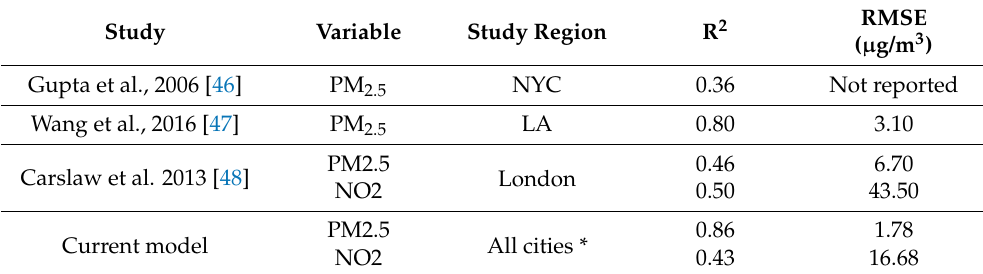
Table 3. Baseline model